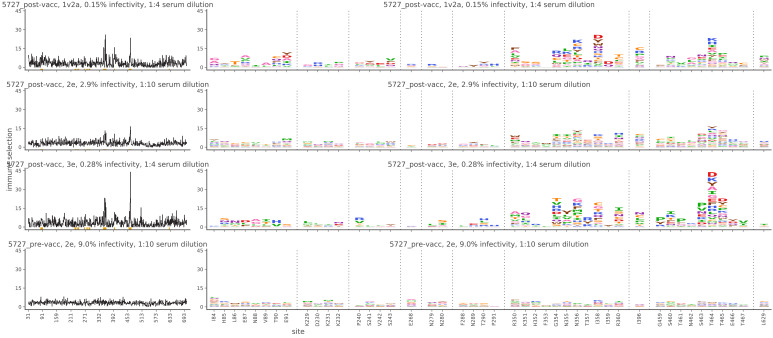
Mutational antigenic profiling data plotted for each individual replicates of pre- and post-immunization sera from rabbit 5727.Data are plotted as in Figure 2A,B for each, but with mutations colored according to their biochemical property rather than epitope.